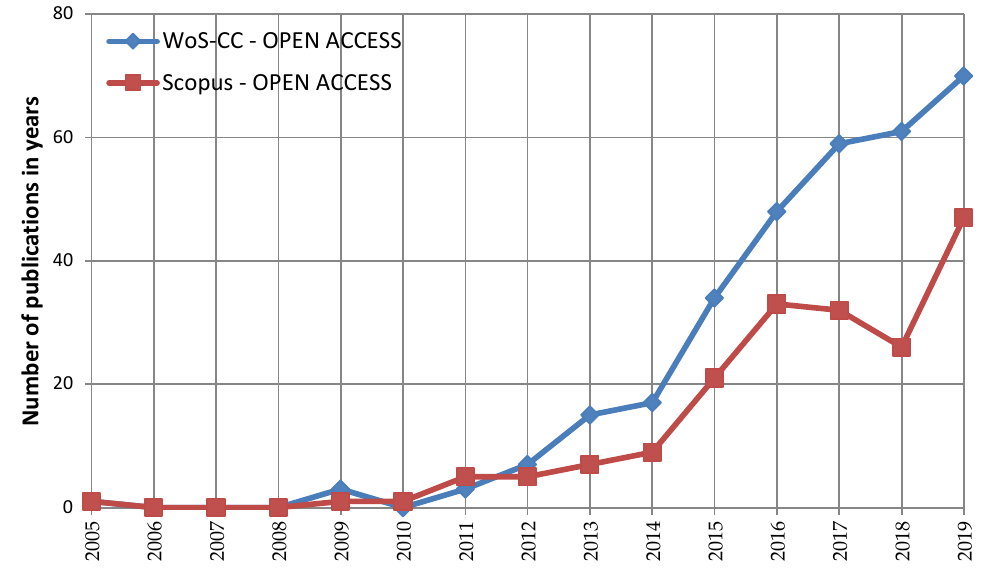
Figure 5. Number of articles in years indexed on WoS-CC and Scopus with Open Access license—2005–2019.